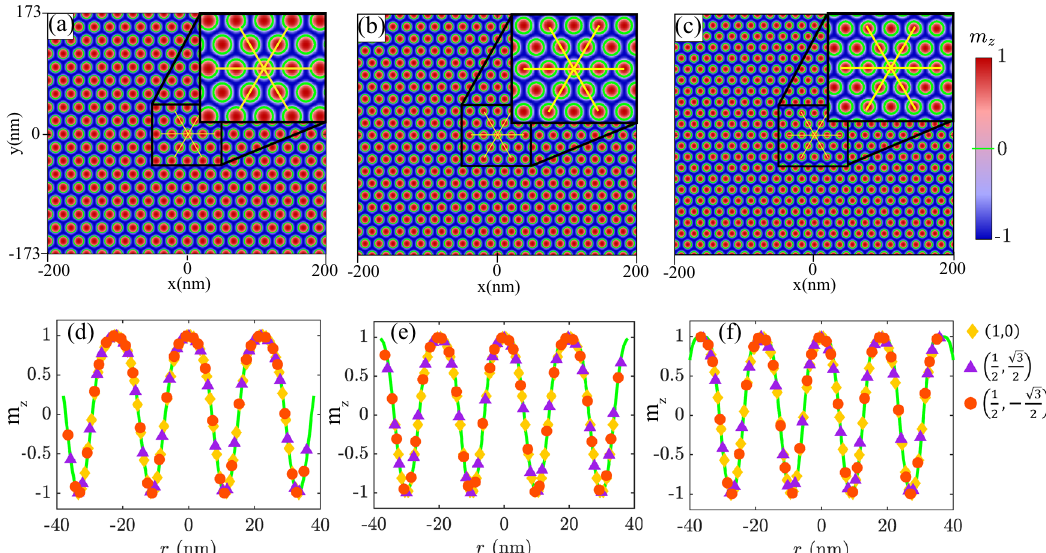
Fig. 3 Skyrmion crystals and skyrmion spin pro fi les at various skyrmion number density. a – c Spin con fi gurations of skyrmion crystals with skyrmion density n = 2.34 × 10 − 3 nm − 2 ( a ), 2.89 × 10 − 3 nm − 2 ( b ), and 3.50 × 10 − 3 nm − 2 ( c ). m z is the z -component of magnetization. d – f Spin pro fi les m z ( r ) along the yellow lines in ( a – c ), respectively. The symbols are numerical data and the solid lines are the theoretical fi ts with skyrmion size R = 7.042 nm ( d ), 6.144 nm ( e ), and 5.399 nm ( f